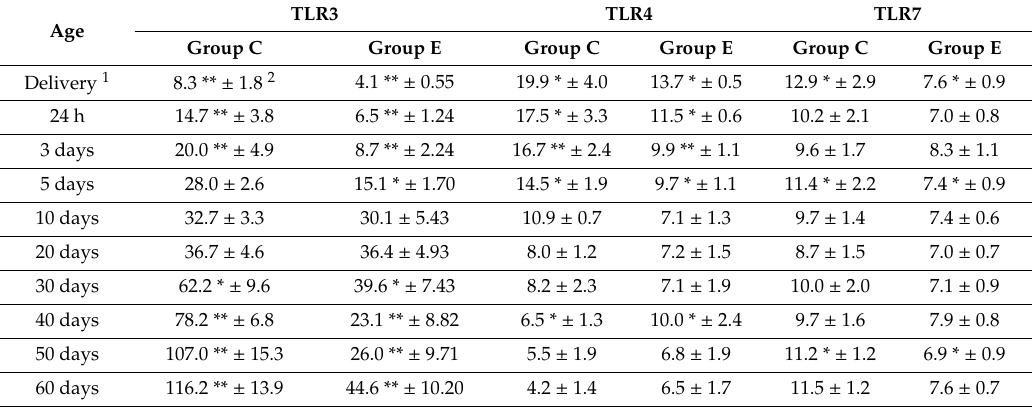
Table 3. Influence of stimulation with Biotropina on the expression of mRNA for selected Toll-like receptors ( TLR3 , TRL4 , TLR7 ) (mean ±